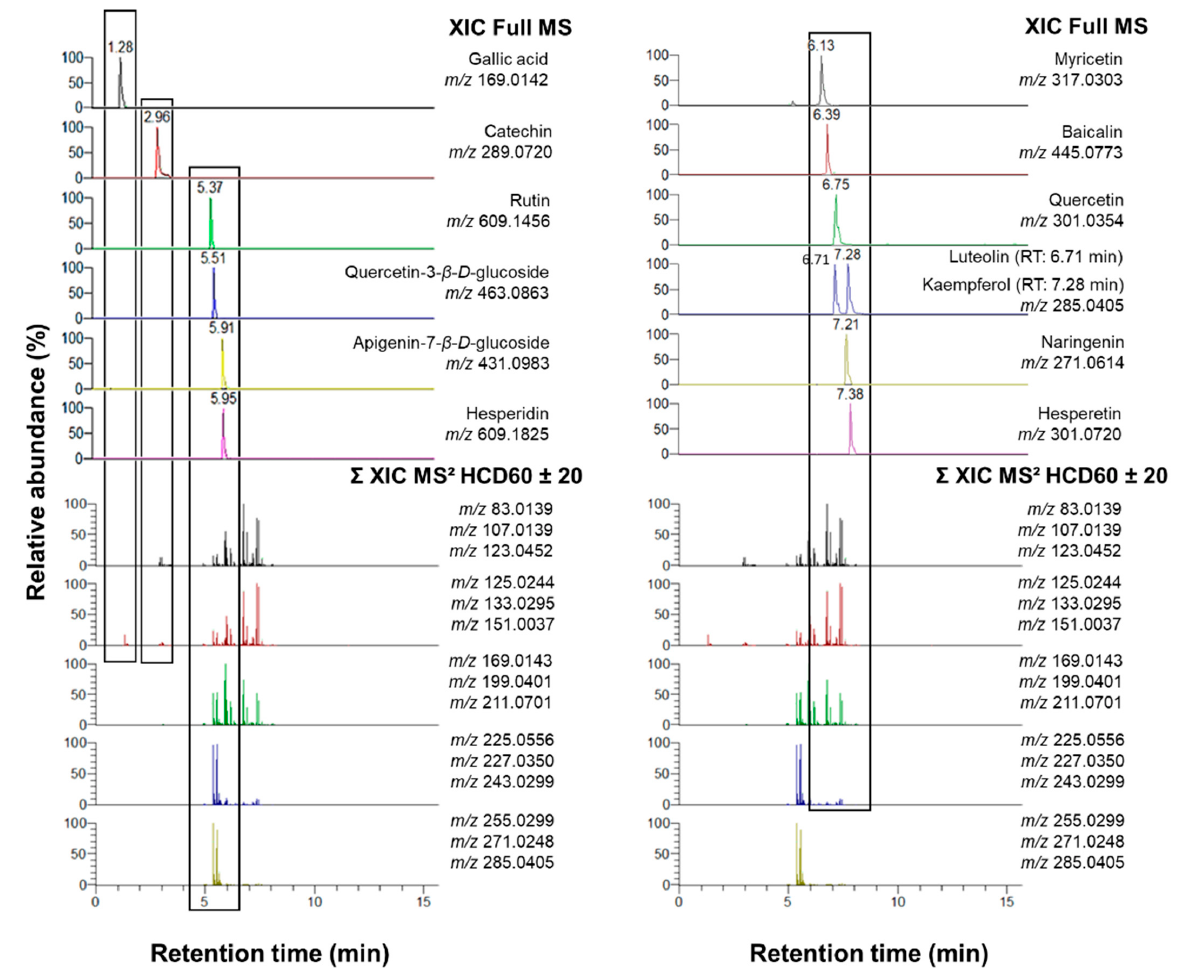
Figure 3. Coverage of fl avonoid standards separated in reversed-phase chromatographic conditions (XIC Full MS) by the sum of extracted ion chromatogram (XIC) traces acquired in stepped HCD60 ± 20 MS 2 scans of the 15 class-speci fi c fragment ions.